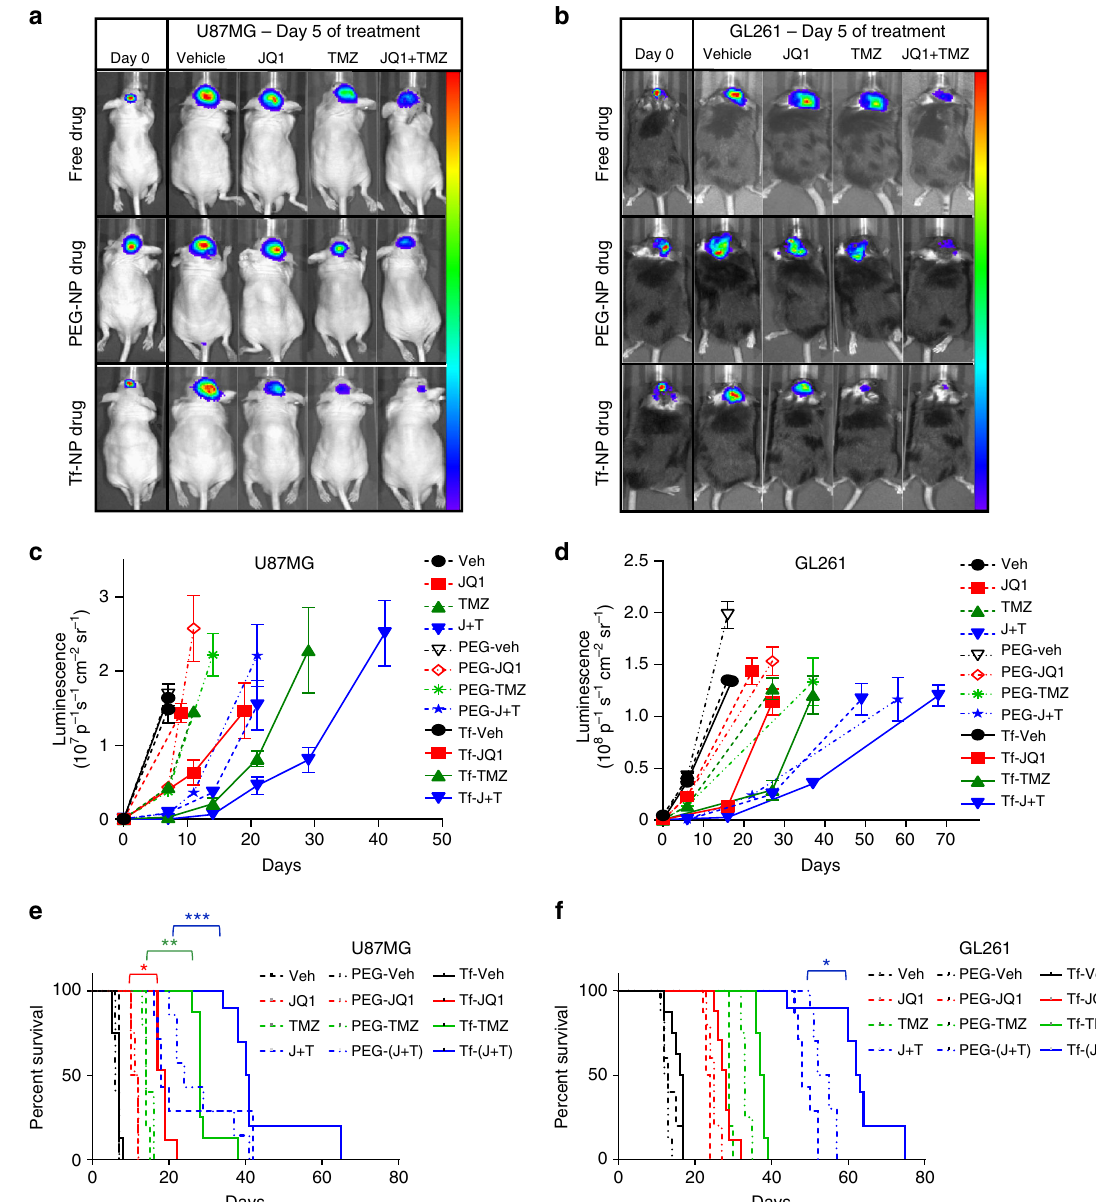
Fig. 5 Tf-NPs loaded with JQ1 and TMZ have superior pharmacodynamic effects in intracranial orthotopic models of glioblastoma. Representative bioluminescent images of a U87MG and b GL261 mice taken on day 0 and day 5 following initiation of treatment with free drug formulations (free drug), drugs loaded in PEG-Cy5.5 liposomes (PEG-NP drug), or transferrin-PEG-Cy5.5 liposomes (Tf-NP drug). Quanti fi cation of average tumor bioluminescence values in the different treatment arms throughout the course of treatment for c U87MG and d GL261 mice. Kaplan – Meier survival plots of e U87MG and f GL261 glioma mice in the different treatment arms. Study powered with eight mice per treatment arm for statistical signi fi cance. Log-rank (Mantel – Cox) test performed on survival plots. Student t -test used to quantify differences in treatment arms (* p ≤ 0.05; ** p ≤ 0.01; *** p ≤ 0.001)